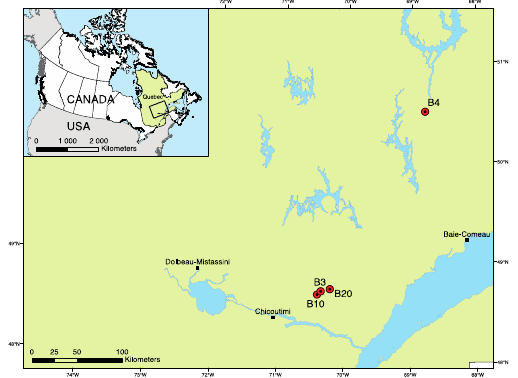
Figure 1. Location of the four sampling sites in the Saguenay–Lac-Saint-Jean (B3, B10, B20) and C ô te-Nord (B4) regions of Quebec,